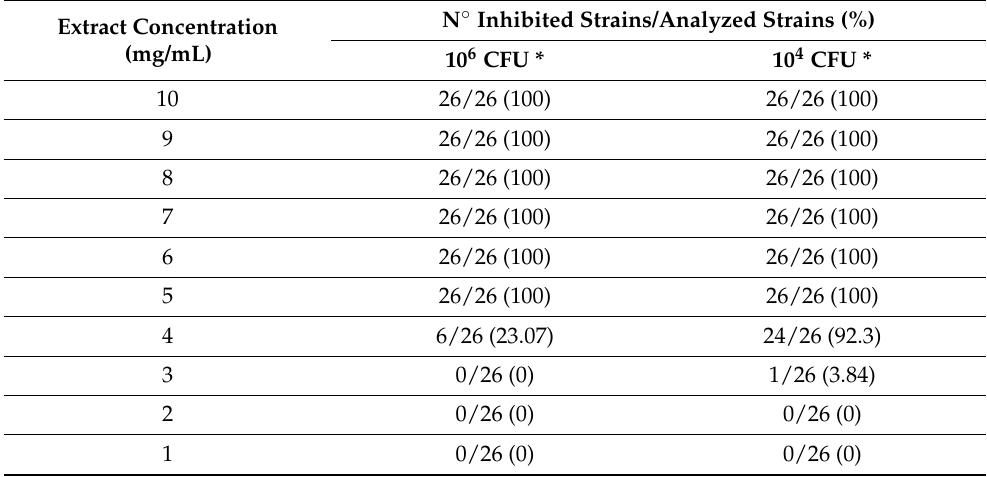
Table 1. In vitro efficacy of AGE with concentrations ranging from 10 mg/mL to 1 mg/mL).